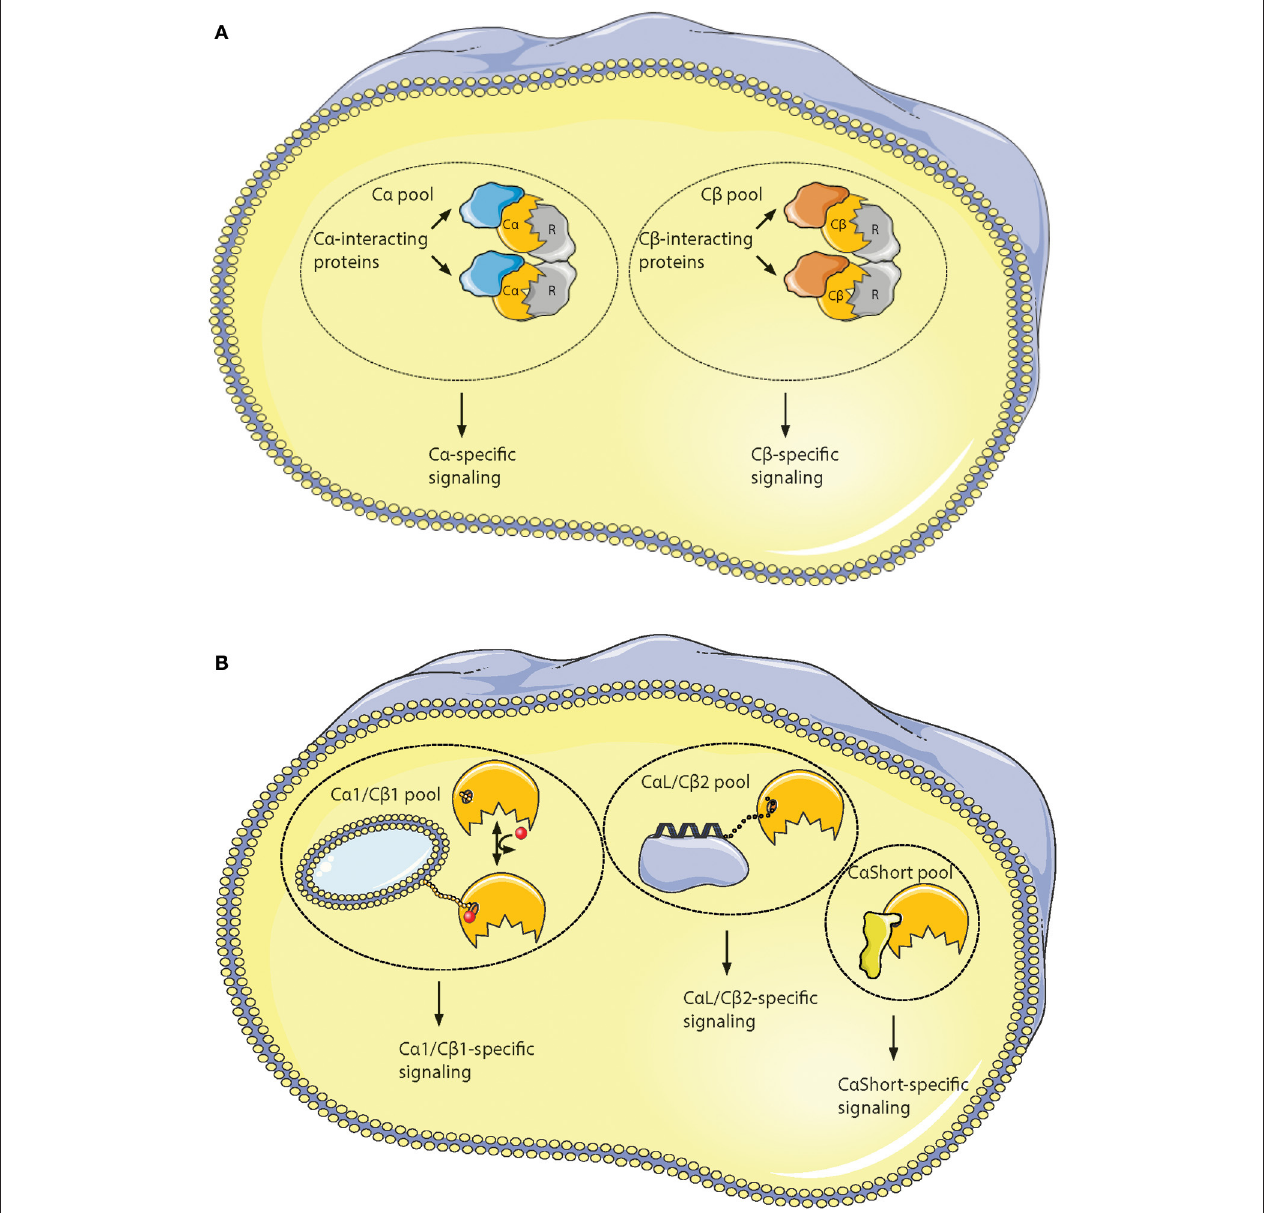
FIGURE 6 | Hypothesis of localized pools of isoform-specific PKA signaling. (A) Most of the variations in the Core 16 − 350 residues in C α and C β proteins are located to 11 solvent exposed residues in the small lobe. This opens for the possibility of C α - and C β -specific interaction partners interacting with the small lobe [described in (196)], possibly locating the two subunits into separate intracellular signaling pools. (B) Evolution of alternative N-termini in C α and C β provides another mechanism for acquiring localized pools of isoform-specific PKA signaling [described in (188)]. The C α 1 and C β 1 pool (left) shares the myristic acid with a regulatory mechanism, evolved in mammals, through phosphorylation/dephosphorylation of Ser10 for switching myristic acid in and out of the hydrophobic pocket (phosphate group presented as a red dot, and myristic acid presented as a yellow chain). This represents the main source of PKA C activity in most human cells. The conserved, putative inducible α -helix opens for the possibility of a C α L/C β 2-specific pool (middle), docking the C subunits via a flexible linker to a C α L/C β 2-specific subcellular assembly of proteins (purple). The C α 2 protein (CaShort pool, right) has a conserved sperm-specific expression in all mammals, and possibly interacts with C α 2-specific proteins (bright yellow) binding to the hydrophobic pocket. Similar C α Short-specific proteins may exist in other tissues in non-mammals. Figure created using the Servier Medical Art resource (http://www.servier.com/Powerpoint-image-bank).